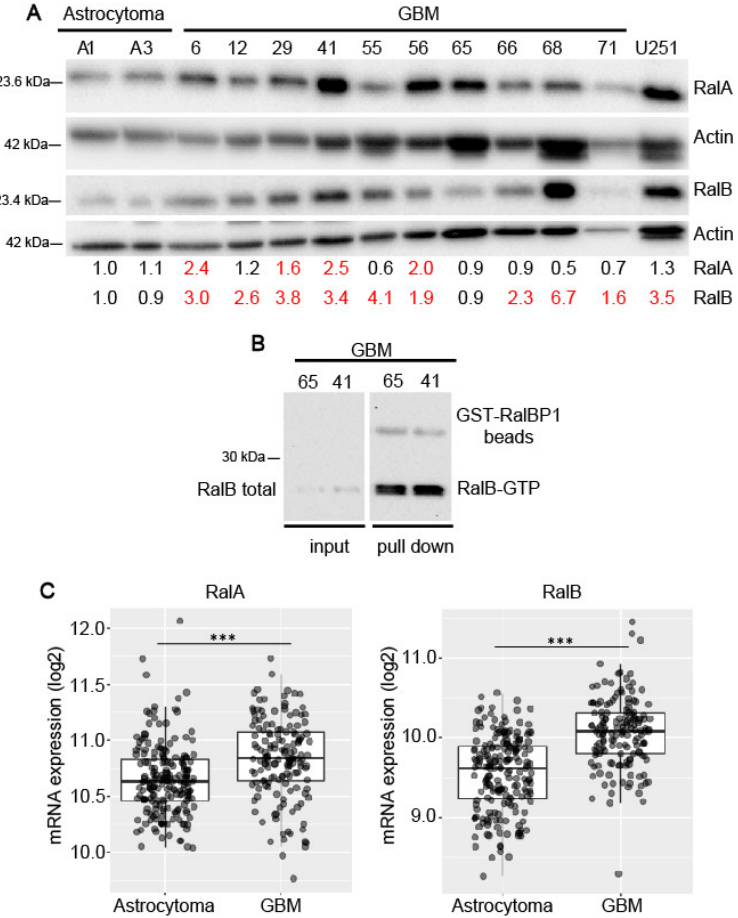
Figure 1. Expression of RalA and RalB in glioblastoma. ( A ) Immunoblot to detect the levels of RalA and RalB in different primary glioblastoma (GBM), in low-grade astrocytoma (A1, A3) primary cultures, and in the glioblastoma cell line U251-MG. β-actin was used as a loading control. Numbers below the panel A are the estimated levels of RalA and RalB relative to β-actin and refer to the astrocytoma sample A1. ( B ) RalB-GTP pull down in two different primary GBM cells. Active RalB-GTP was affinity purified with Ral BP-beads from cell lysates. RalB-GTP and total RalB were detected by immunoblot. Ral BP-beads were used as a loading control. ( C ) Analysis of RalA and RalB mRNA expression levels by RNAseq from GlioVis database (161 low-grade astrocytoma and 152 glioblastoma samples). Tukey's Honest Significant Difference (HSD), p < 0.001 (***) (http://gliovis.bioinfo.cnio.es/, accessed on 5 July 2022).